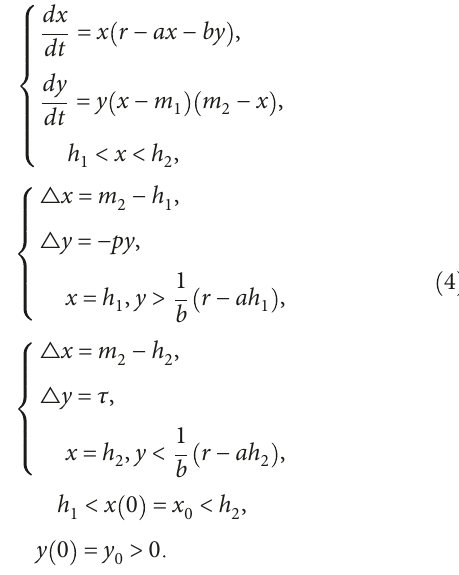
< 1 − q = m < h 1 2 2 of system (3). 1 h 2